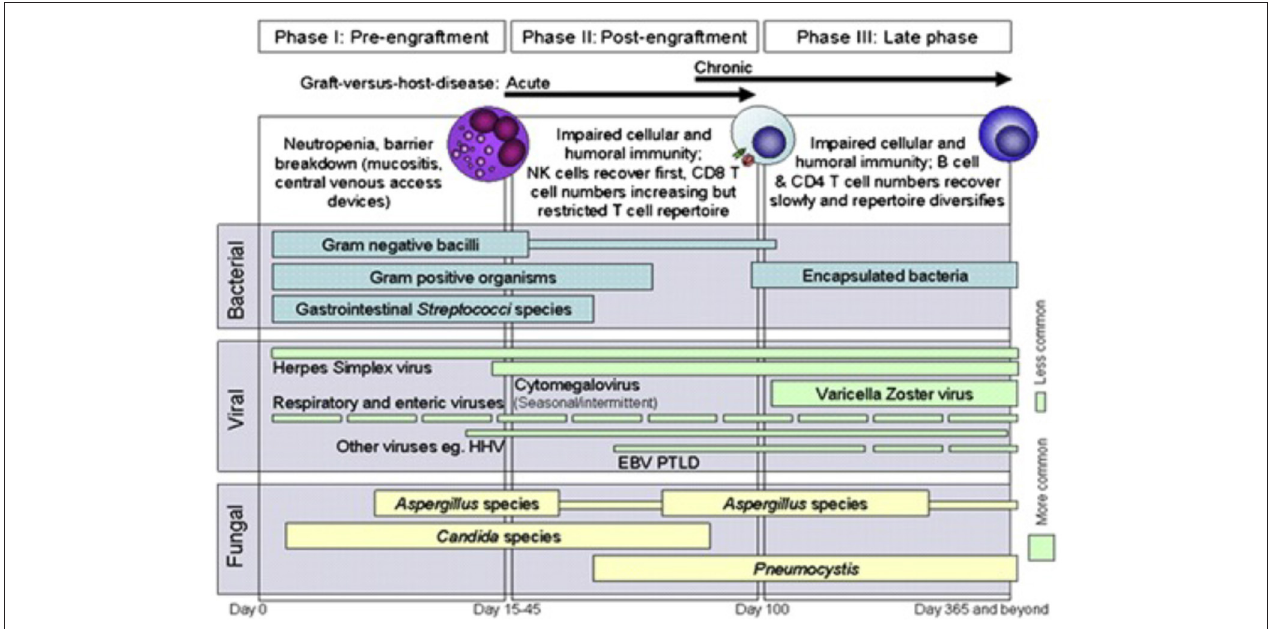
FIGURE 2 | Phases of opportunistic infections among allogeneic HCT recipients. EBV, Epstein-Barr virus; HHV6, human herpesvirus 6; PTLD, post-transplant lymphoproliferative disease. Reprinted from Tomblyn et al. (21). Copyright 2009 by Elsevier, Reprinted with permission.